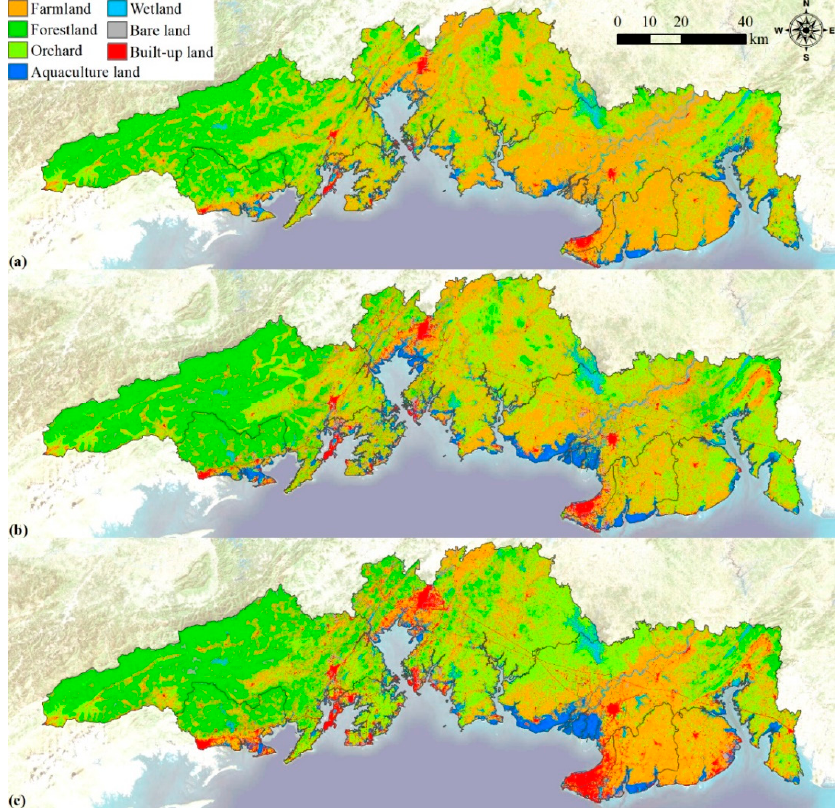
Figure 3. The territorial spaces and land-use pattern in 2000 ( a ), 2010 ( b ) and 2020 ( c ).